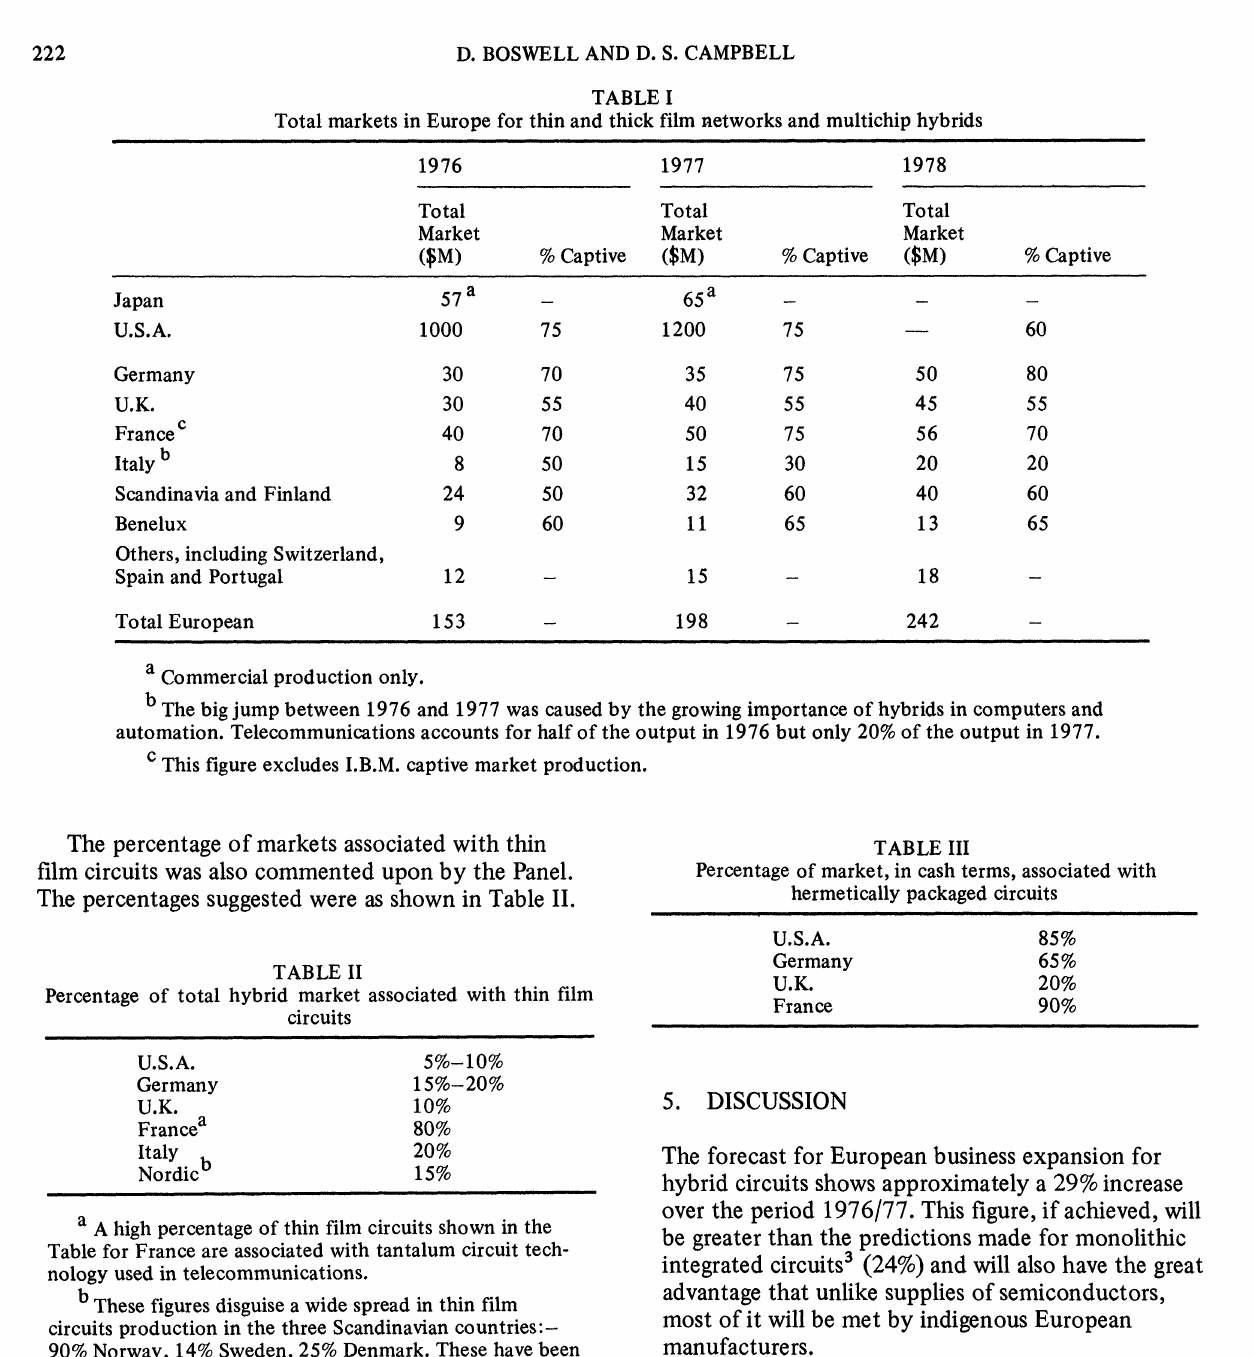
TABLE Total markets in Europe for thin and thick film networks and multichip hybrids